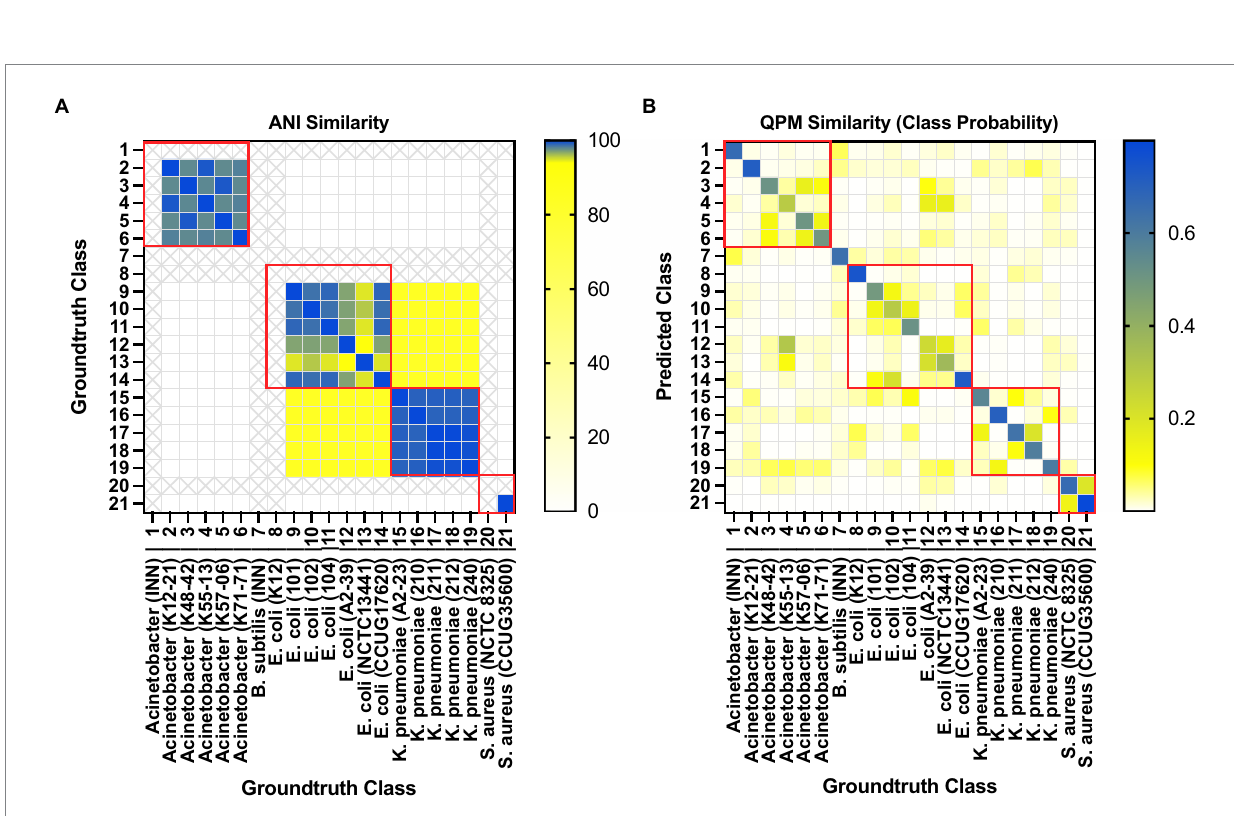
FIGURE 9 (A) Average nucleotide identity (ANI) based similarity between bacteria classes. Classes representing isolates that were not sequenced are shown in “X”s. (B) The equivalent QPM-based similarity between bacteria classes. Here the probability of strain level class predictions (averaged over all test instances for each class) was used as the similarity